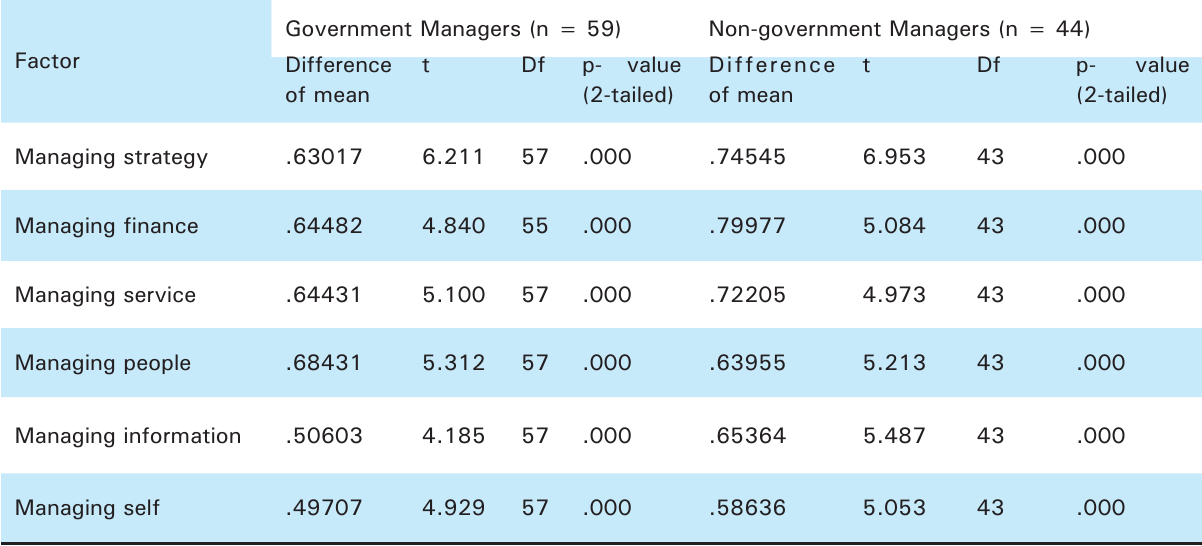
Table 3. Mean difference between reported importance and capability scores – Student’s t statistics and two-tailed signi fi cance for Government and non-government managers